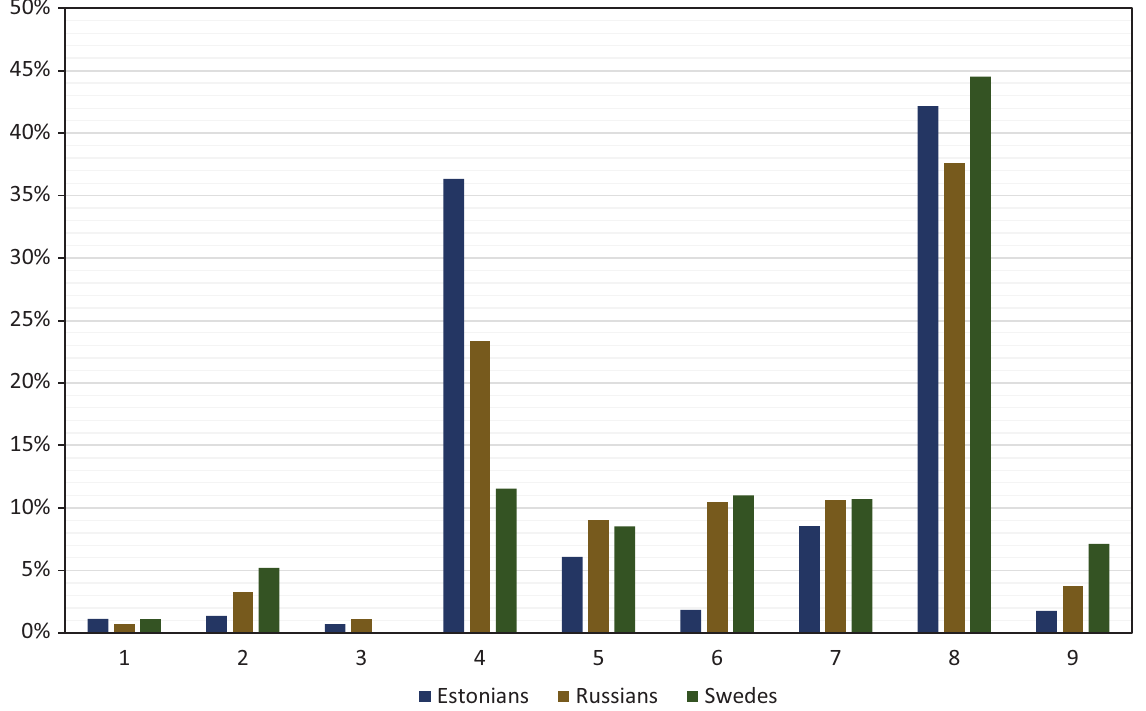
Figure 1. Distribution of ethnic groups (as a share of employed ethnic group members in a particular industry from the total number of employed ethnic group members) across industries in 2013. The aggregated industrial classification based on TOL 2008: (1) Manufacturing; (2) Mining and quarrying; (3) Electricity, gas, steam, air and water supply; (4) Construction,